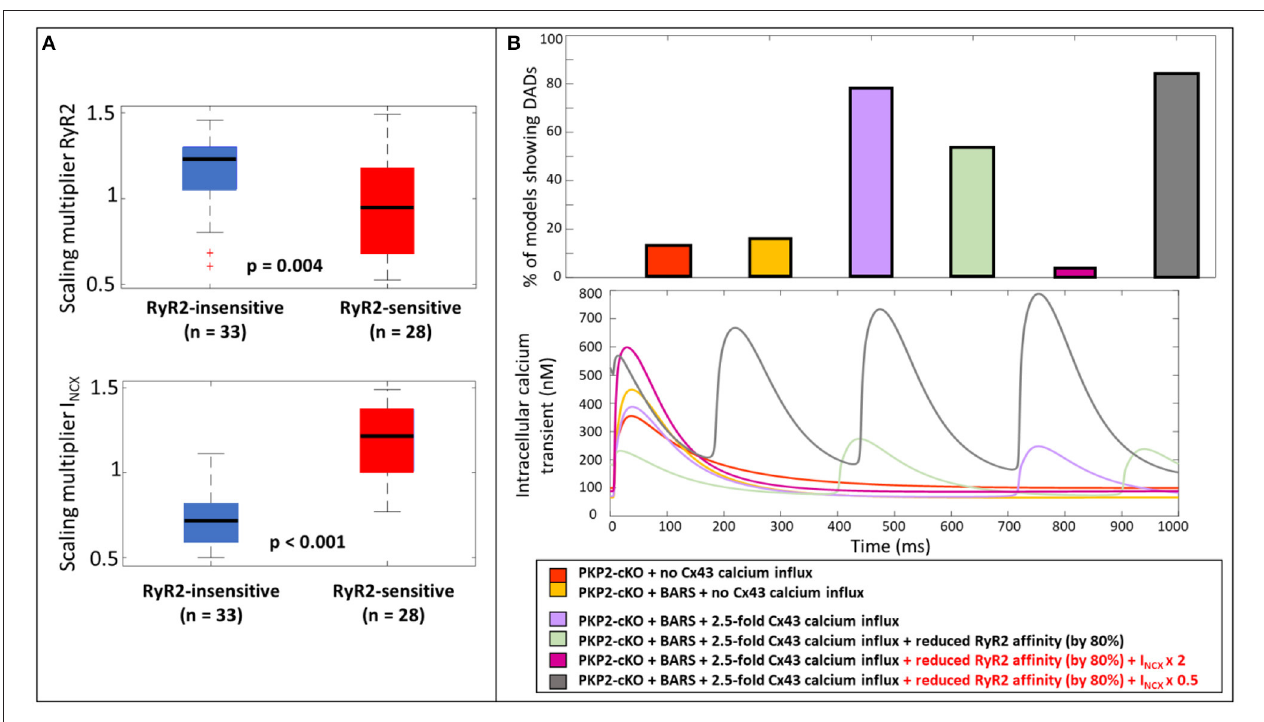
FIGURE 6 | (A) Scaling multiplier of RyR2 and I NCX between models that still show DADs after a reduction in RyR2 calcium affinity (RyR2-insensitive, blue) and the ones who do not show DADs after reduction (RyR2-sensitive, red). (B) Percentage of models showing DADs when comparing; the PKP2-cKO model with no Cx43 hemichannel-mediated calcium influx, PKP2-cKO model plus BARS (1.5-fold Cx43 hemichannel-mediated calcium influx incorporated), with or without reduced RyR2 affinity, the PKP2-cKO model plus BARS (1.5-fold Cx43 hemichannel-mediated calcium influx), with or without reduced RyR2 activity, doubled I NCX in the RyR2-insensitive group or a 50% reduction of I NCX in the RyR2-sensitive group (top); the corresponding calcium traces